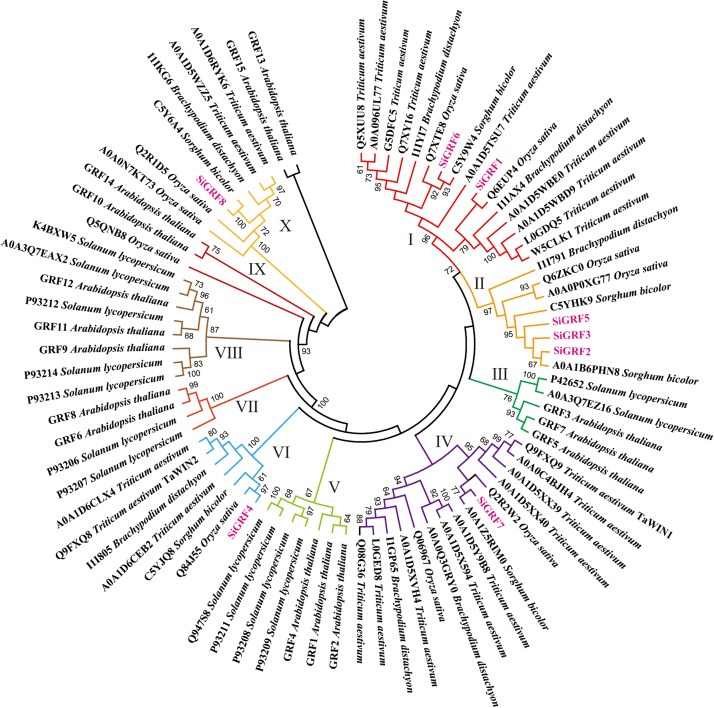
Neighbor-joining distance tree of 14-3-3 proteins in seven species. The tree is presented radially so that distances from the center represent cumulative branch lengths. Terminal branches and labels are colored to indicate different groups and foxtail millet (pink).